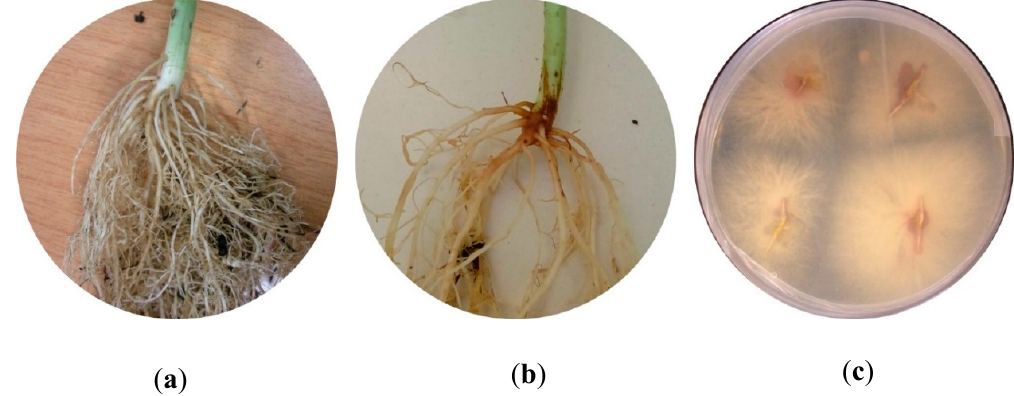
Figure 3. Bean symptoms in hypocotyl and root system of ( a ) control treatment and ( b ) infected plant. ( c ) Petri plate with infected hypocotyls showing Fusarium growth (re-isolation).